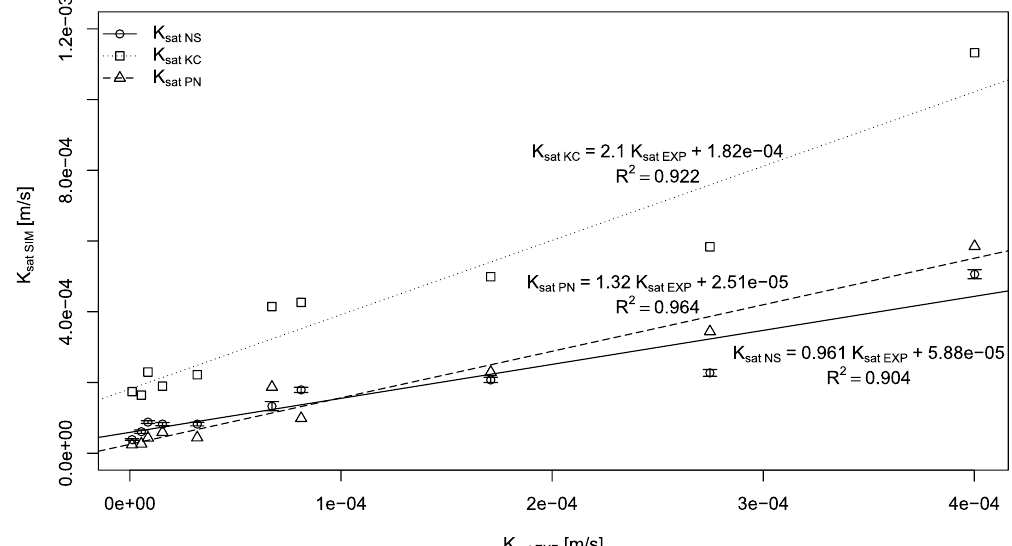
Figure 5. Comparison between measured and simulated water conductivities (K satEXP —experimentally determined values for specimens, K satSIM —values determined based on: NS, PN, and KC estimations; figure created using RStudio 1.3 software https ://rstud